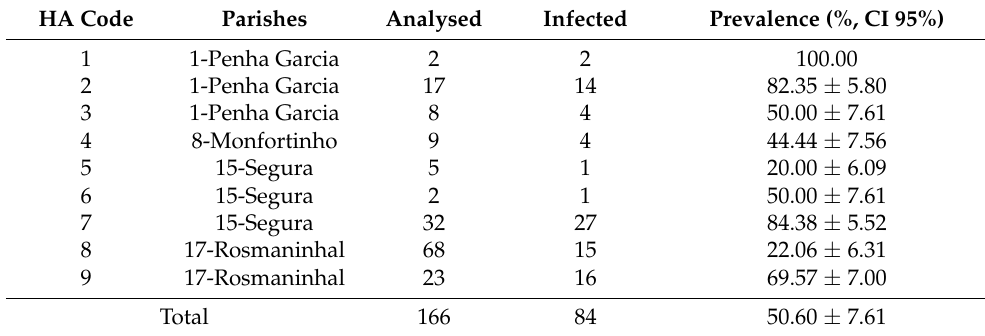
Table 1. Oestrosis prevalence in red deer in each hunting area